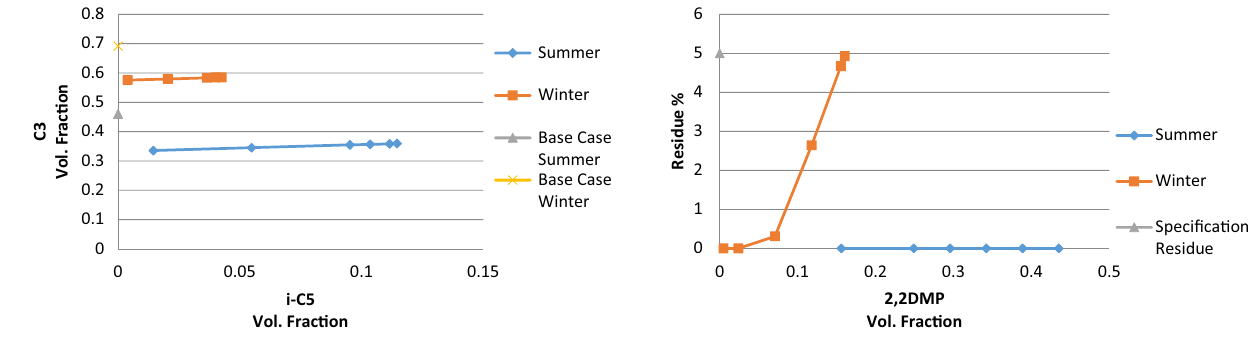
Fig. 33 Effect of adding i-C5 and 20 vol% DME on LPG propane